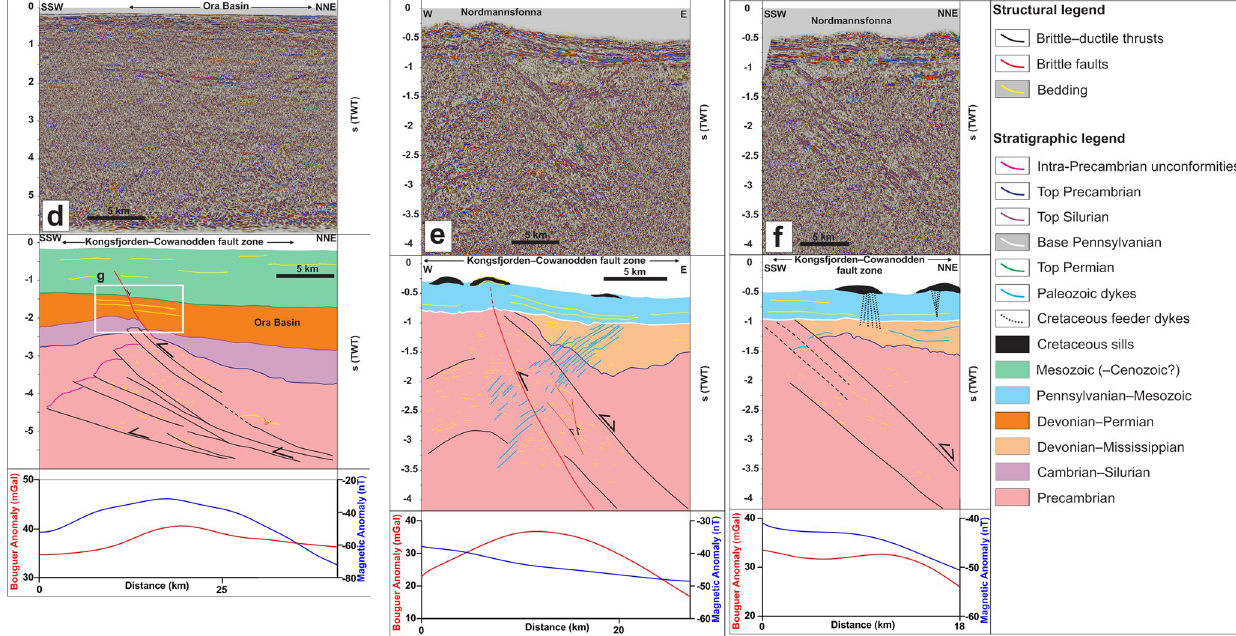
Figure 3. Interpreted seismic profiles and associated potential field data (a) in Storfjorden, (b) south of Hopen, (c) on the Stappen High in the northwestern Norwegian Barents Sea between Spitsbergen and Bjørnøya, (d) on the southern flank of the Ora Basin in the northeastern Norwegian Barents Sea, and ( e and f ) in Nordmannsfonna in eastern Spitsbergen. The seismic profiles show top-SSW Timanian thrusts that were reactivated and overprinted during subsequent tectonic events such as Caledonian contraction, Devonian–Carboniferous late–post Caledonian collapse and rifting, Eurekan contraction, and present-day contraction. Profiles (e) and (f) also show Paleozoic and Cretaceous intrusions. The white frames show the location of zoomed-in portions of the profiles displayed in Fig. 4. Potential field data below the seismic profiles include Bouguer anomalies (red lines) and magnetic anomalies (blue lines). The potential field data show consistently high gravimetric anomalies and partial correlation with high magnetism towards the footwall of each major thrust system (i.e., towards thickened portions of the